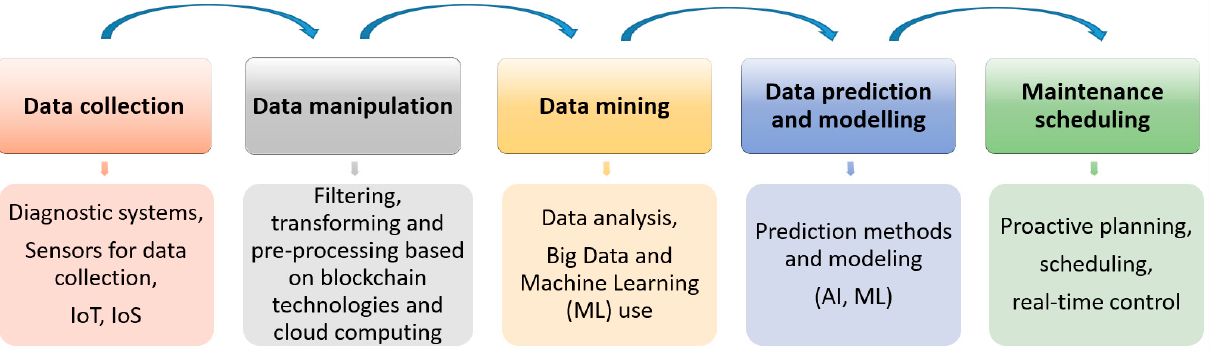
Figure 24. Data-driven decision-making in maintenance. Source: own contribution based on